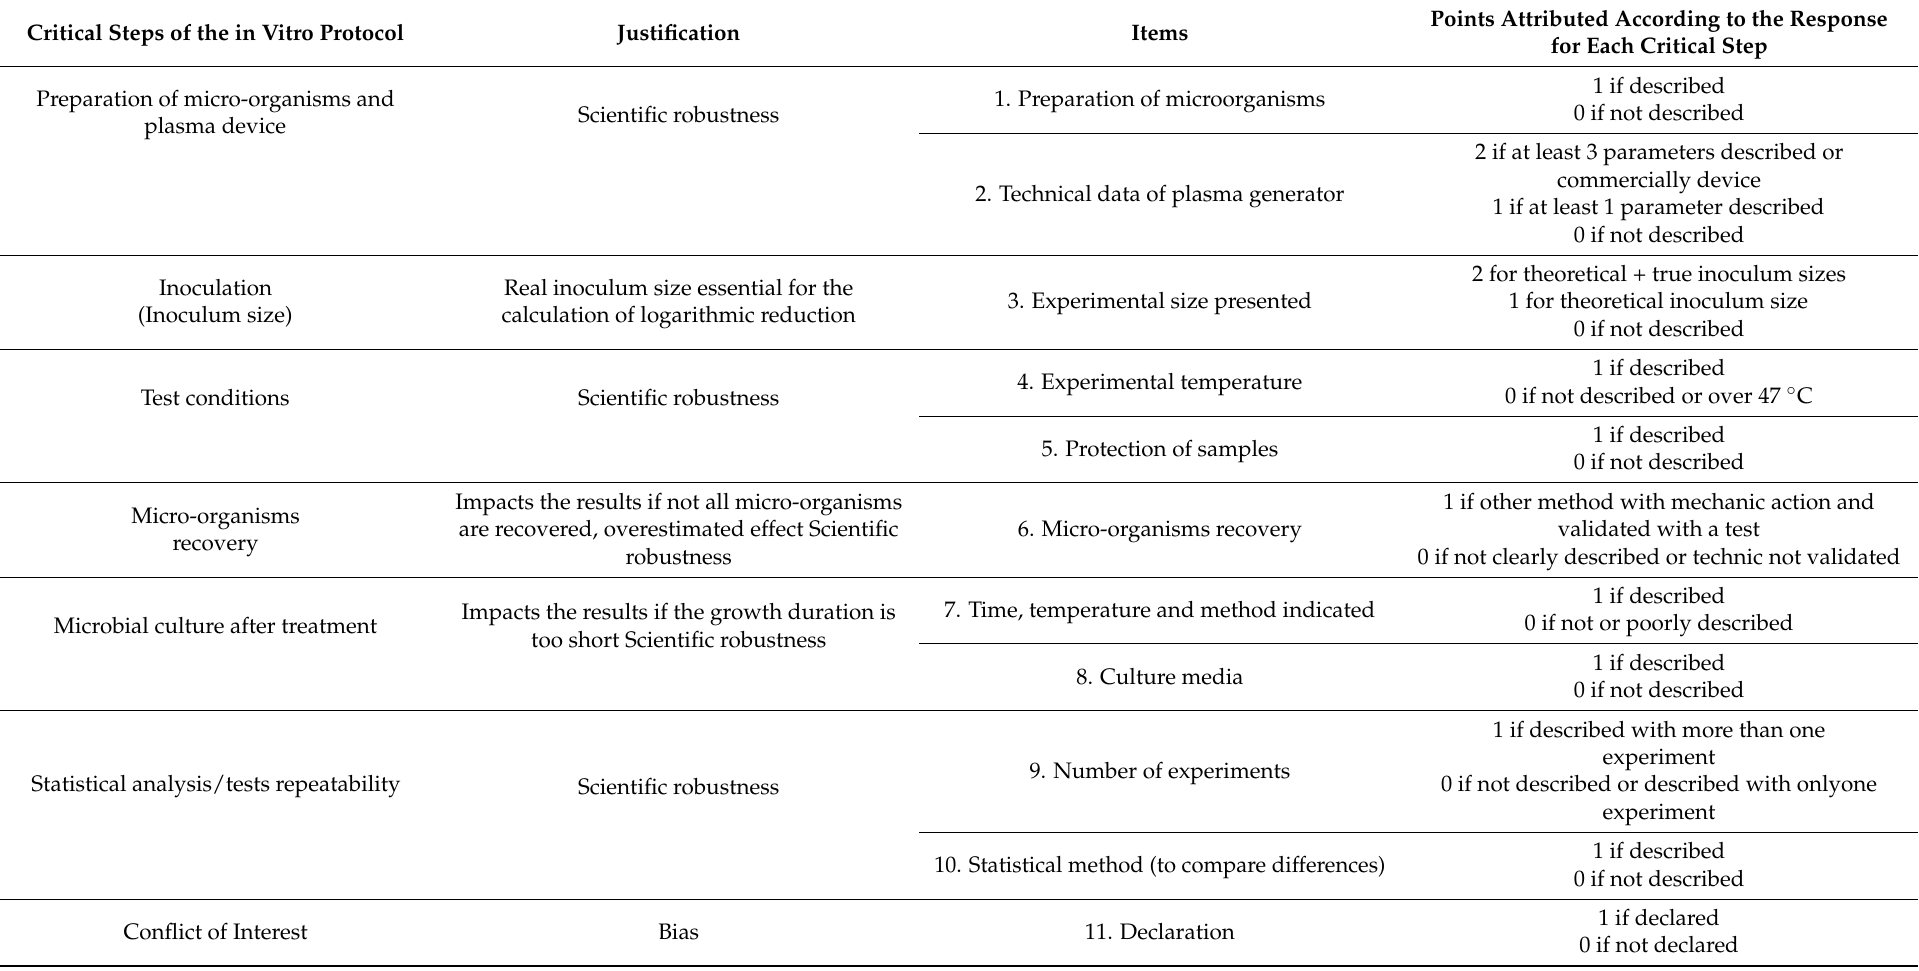
Table 1. Quality assessment